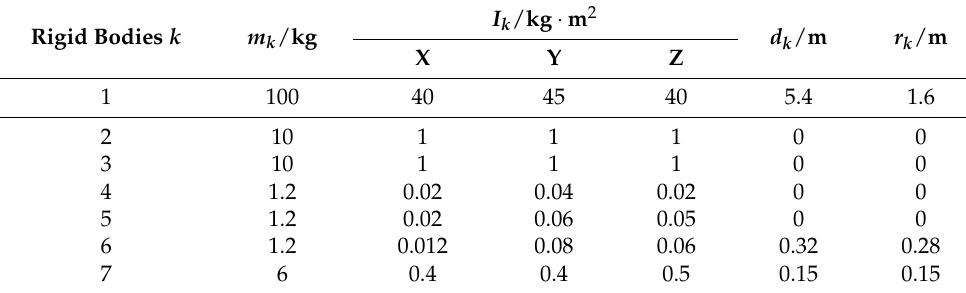
Table 1. Dynamic parameters of the SMS-FDCDM model.